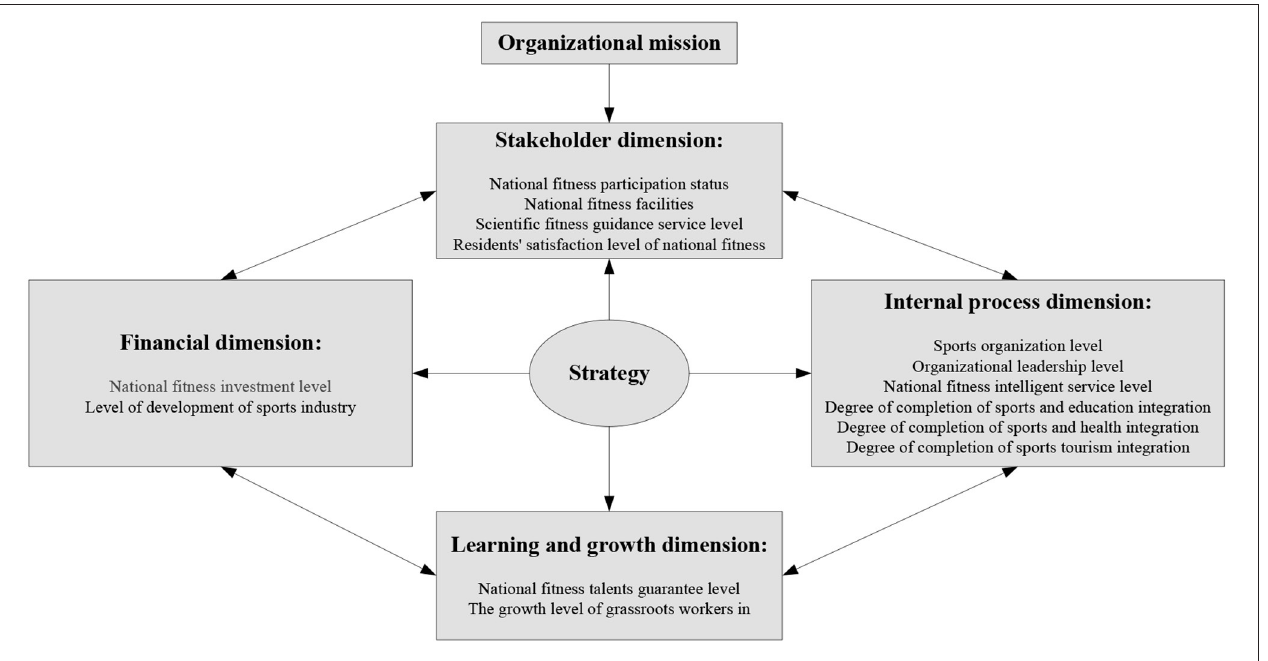
FIGURE 1 | National fitness balanced scorecard